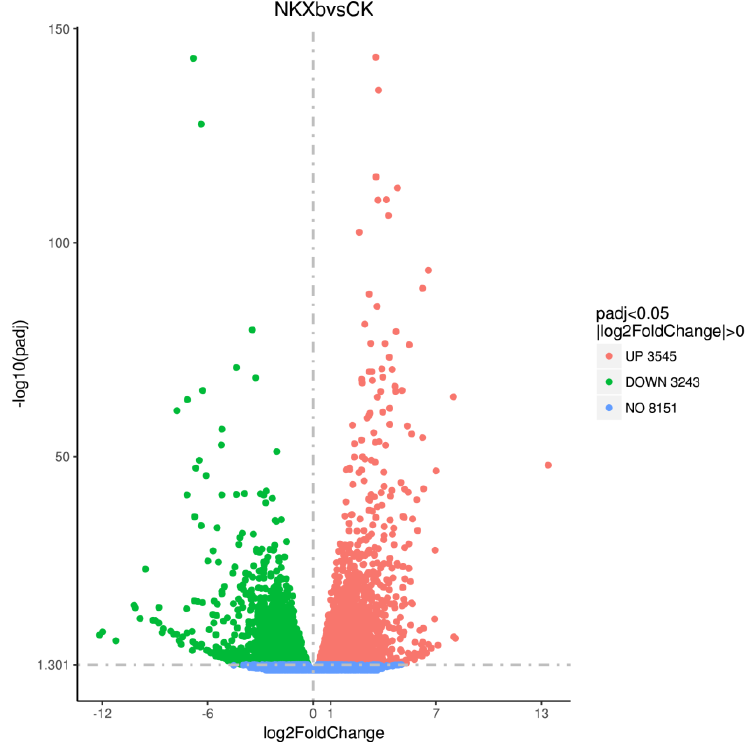
Figure 6. Mass spectrogram. ( a ) The retention time is 35.629 min, indicative of 2-pentanone, 3-(phenylmethyl); ( b ) the retention time is 37.685 min, indicative of 1-hexen-3-one, 5-methyl-1-phenyl.